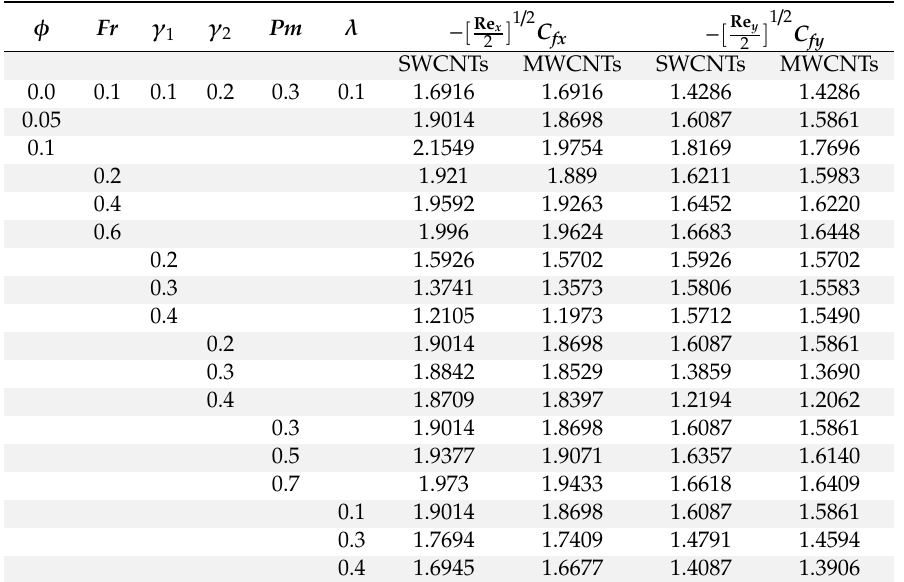
Table 2. Numerical value of skin friction for engine oil base fluid for various parameters.